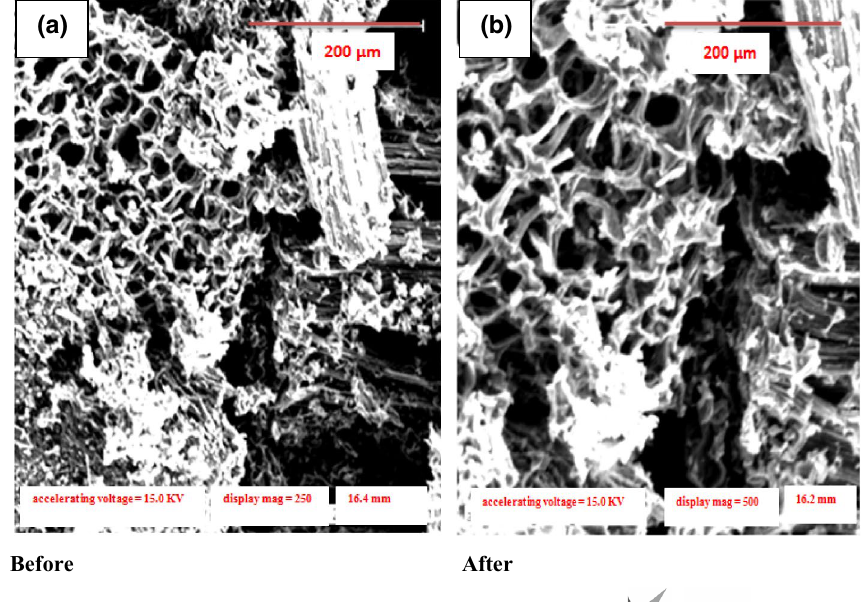
Fig. 8 SEM micrograph of AESA before and after adsorp-